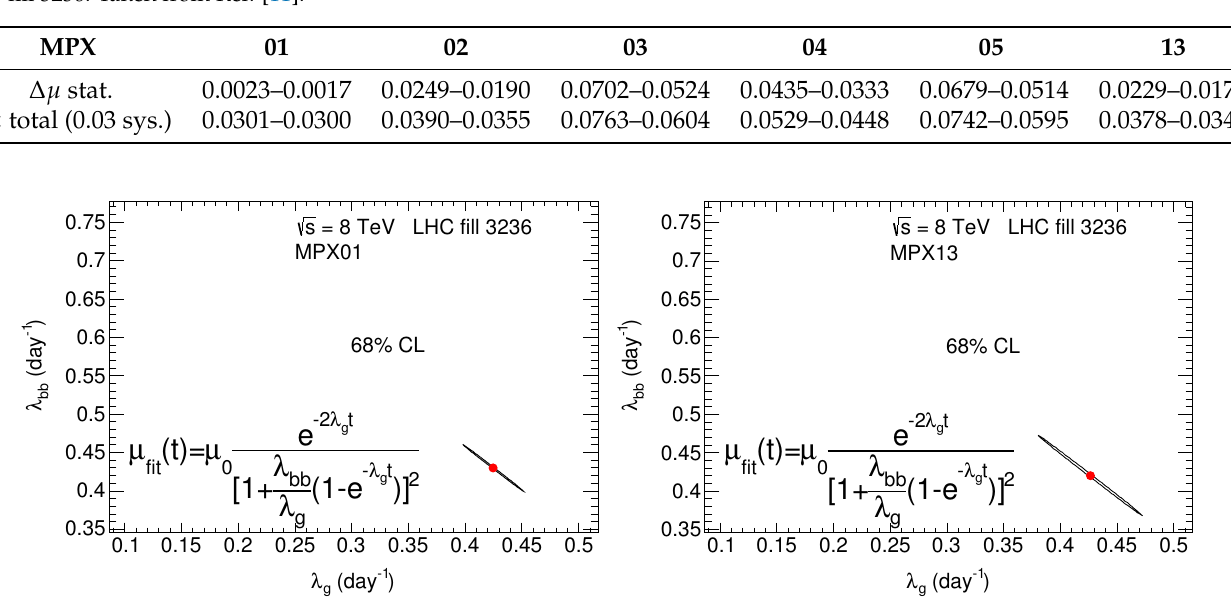
Figure 17. Contour curves of λ g and λ bb , given at 68% CL, for the fit results of the average number of interactions per bunch crossing as a function of time seen by MPX01 and MPX13. The dot in the center of the contour indicates the fit values. The hit statistical uncertainties and systematic uncertainties from luminosity fluctuations not described by the fit function are added in quadrature, given in Table 9. The χ 2 values are 528, 1811, 2666, 1415, 1720 and 1078, for MPX01-05 and MPX13 respectively, for 499 degrees of freedom. LHC fill 3236. Taken from Ref. [11]. Table 9. Statistical uncertainty ranges for the data points in Figure 11. The uncertainty resulting from the number of hits is (cid:112) N hit / N cl , given in Table 5. The values are given for the beginning and end of the fit range. Shown also scaled by a factor are the total uncertainties calculated adding in quadrature the statistical and systematic uncertainties, where the systematic uncertainties result from luminosity fluctuations not described by the fit function ( σ fct sys = 0.03), shown in Figure 12. LHC fill 3236. Taken from Ref. [11].